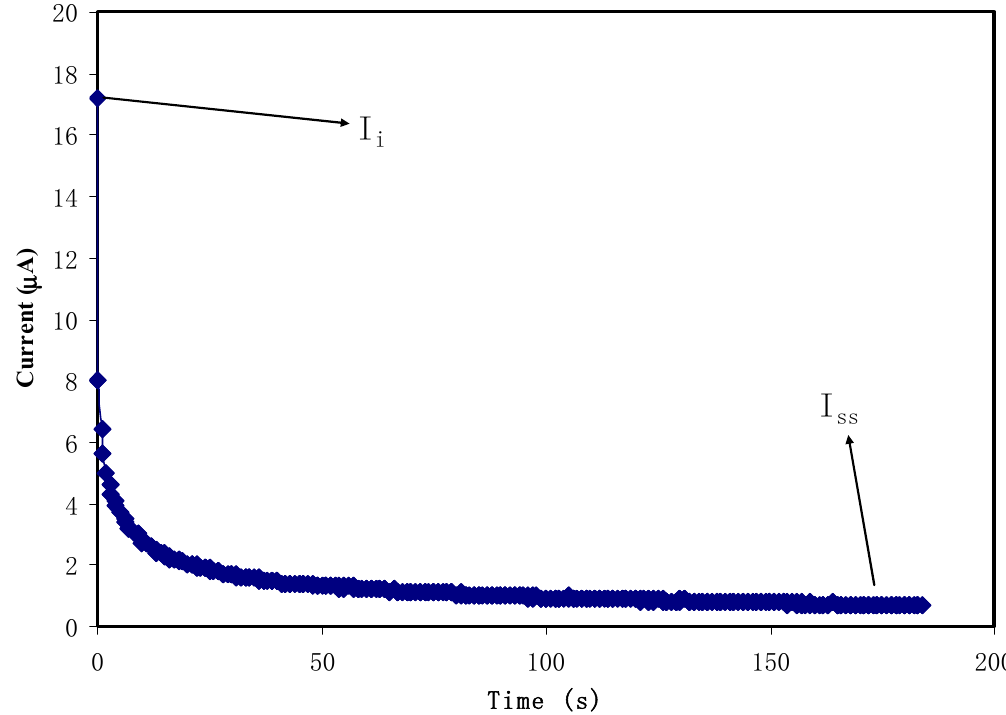
Figure 5. Polarization current against time for the prepared polymer electrolyte sample.